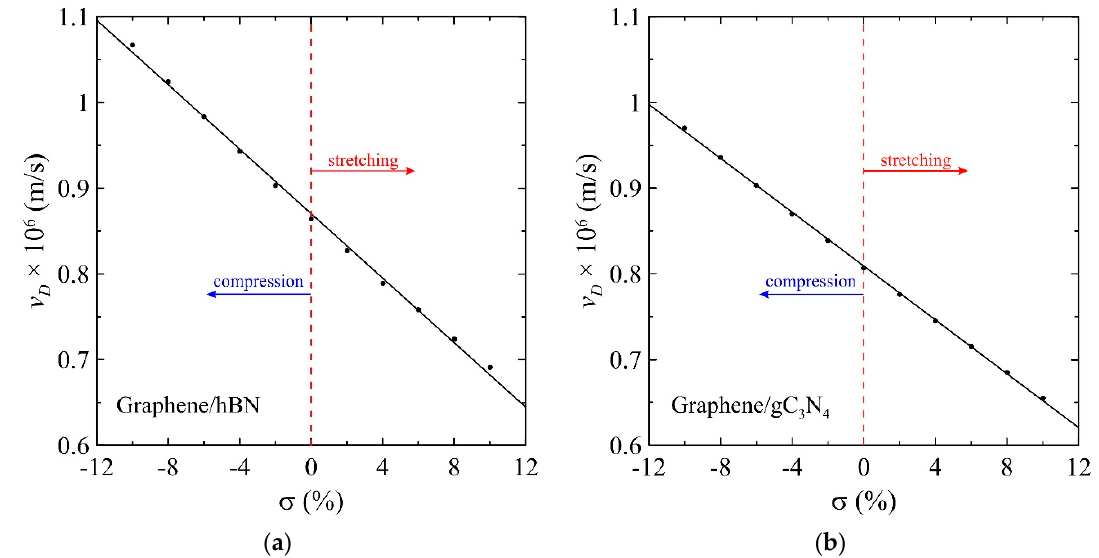
Figure 4. Dirac velocity dependence on the uniform biaxial strain of the graphene deposited on the h BN ( a ) and g C 3 N 4 ( b ) substrates. Circles are the results of the calculation and the solid lines are the least-squares linear fits.